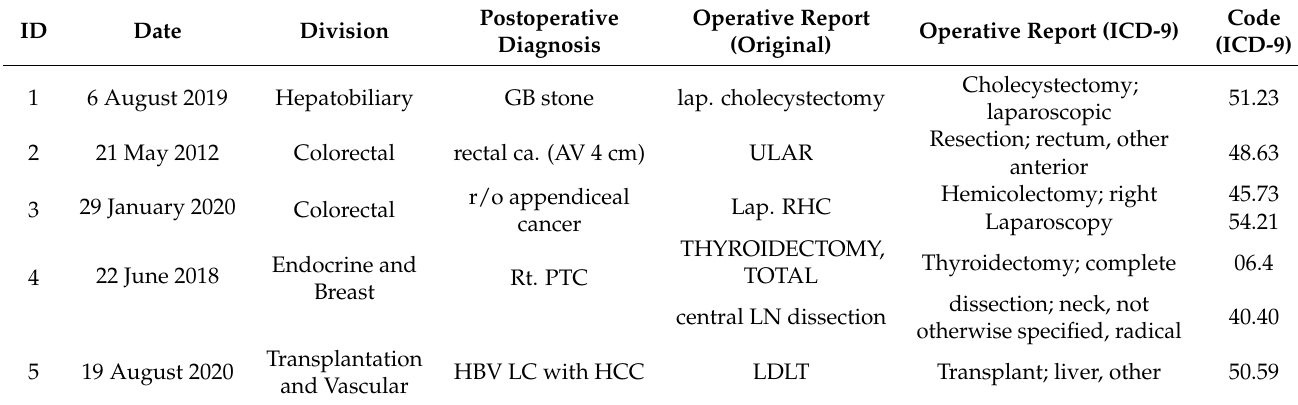
Table 1. Surgical records in the dataset.